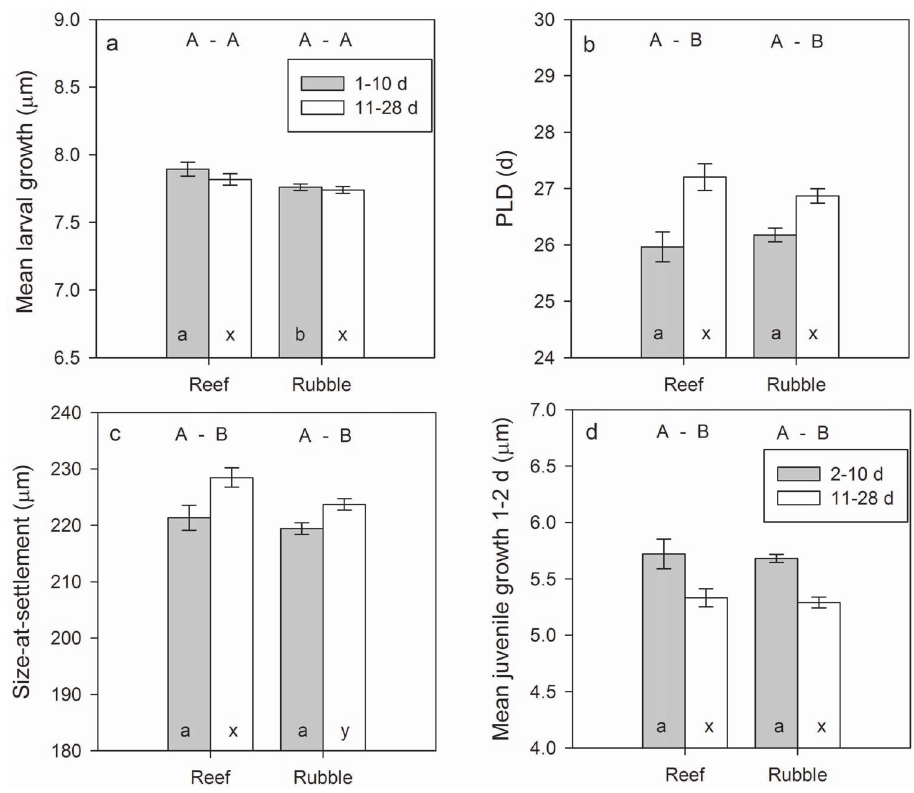
Figure 4. Mean otolith-derived (a) larval growth, (b) pelagic larval duration (PLD), (c) size-at-settlement, and (d) early (2 d) juvenile growth for two different age groups of Stegastespartitus recruits by habitat type (i.e., reef crest and rubble). Effect of temperature was minimized by including only 25 monthly cohorts collected from May 2003 to August 2008 that encountered mean water temperatures of . 28 u C. Error bars are SE. Different letters above the bars indicate significant relationships between habitats for a given age group. Different letters within the bars indicate significant relationships between age groups (selective mortality) by habitat (a, b denote differences between recruits (1–10 d post- settlement) and juveniles (11–28 d) in reef habitats, x, y denote differences between recruits and juveniles in rubble habitats.